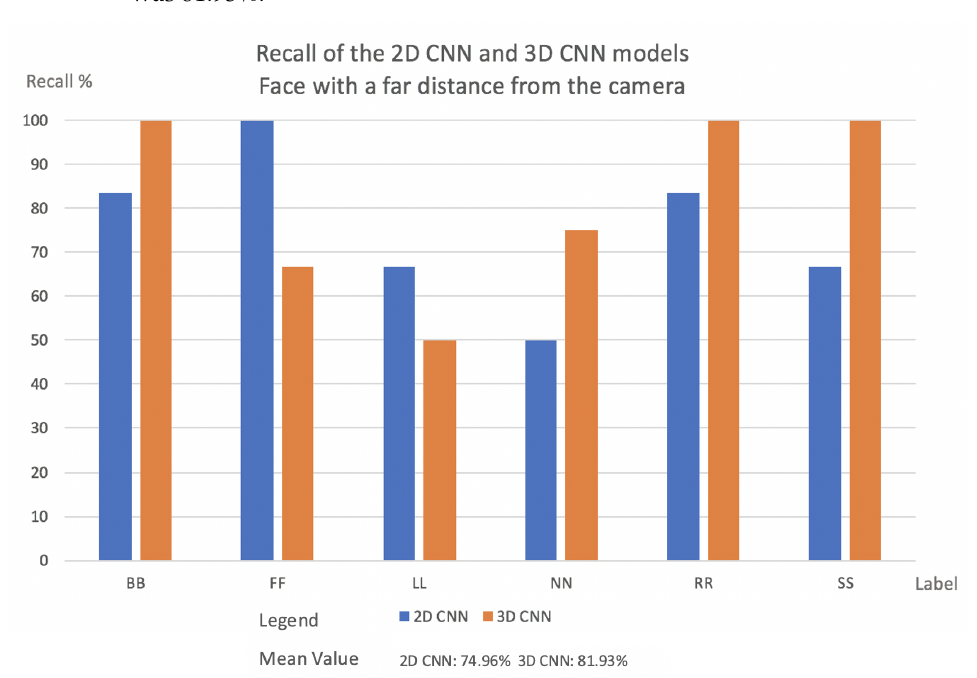
Figure 6. The percentage of labels successfully classified by the network in both models for videos facing the camera at a far